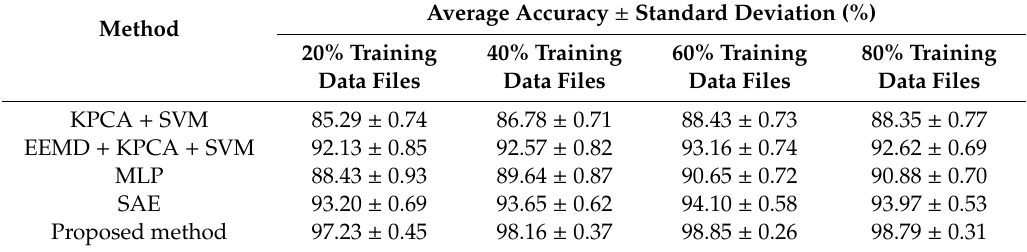
Table 5. Comparison of di ff erent diagnostic methods.